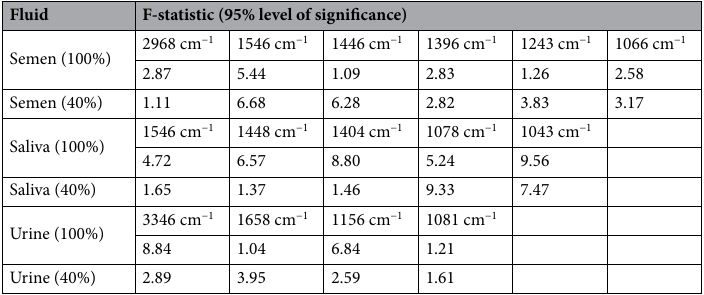
Table 5. Calculated F-statistics by one way ANOVA for all the age-linked peaks of three body fluids.